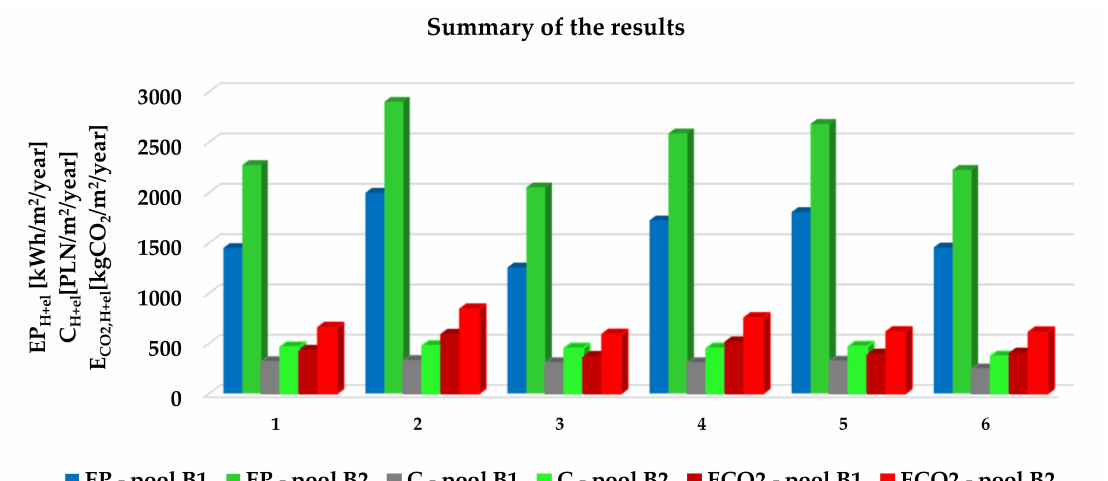
Figure 6. Calculated indicators of primary energy EP H + el , CO 2 emissions E CO2,H + el , and operating costs C H + el —sports pool B1 and recreation pool B2.